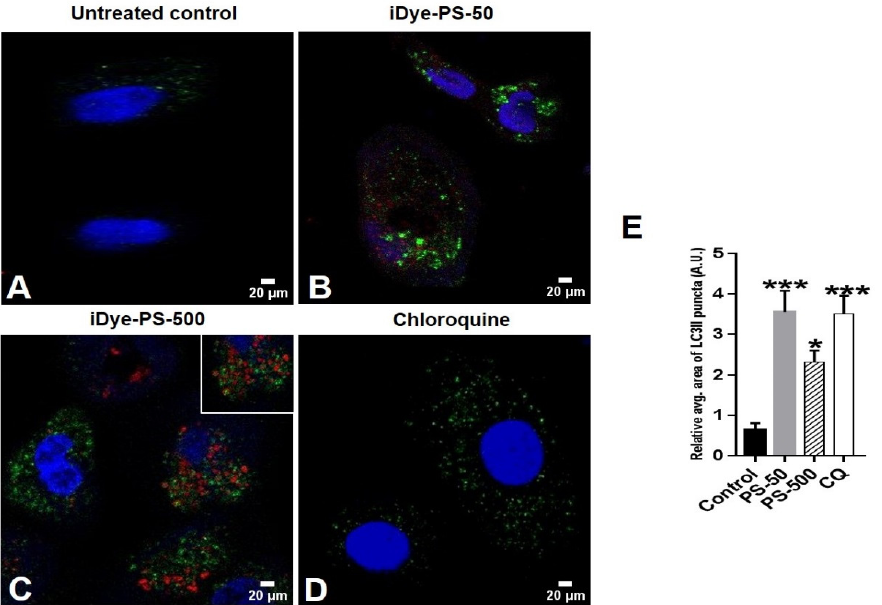
Figure 7. The confocal images represent the accumulation of LC3II (green) after exposure of HNEpCs to 100 µ g/mL of iDyePS-50 (red) and iDyePS-500 (red) for 24 h. ( A ) Untreated control. ( B ) Concurrent presence of iDyePS-50 (red) and LC3II puncta (green) in cytoplasmic regions. ( C ) Overlapping of iDyePS-500 (red) and LC3II (green) in cytoplasmic regions or colocalization of iDye-PS500 and LC3II (yellow, shown in inset). ( D ) chloroquine as a positive control for LC3II (green). ( E ) The histogram depicts the measurement of the relative average area of fluorescence (green/LC3II puncta, AU) due to iDyePS-50 and iDyePS-500 over the untreated control. * p ≤ 0.05, *** p ≤ 0.001 vs. untreated control.